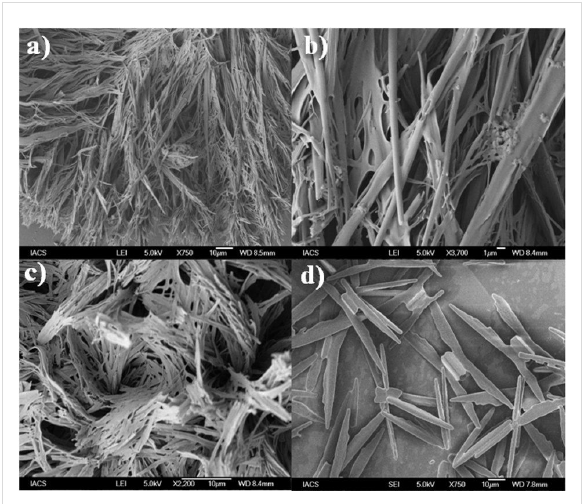
Figure 2: DSC of a 4.0 wt % 1,2-dichlorobenzene gel of DBAMC 6 .